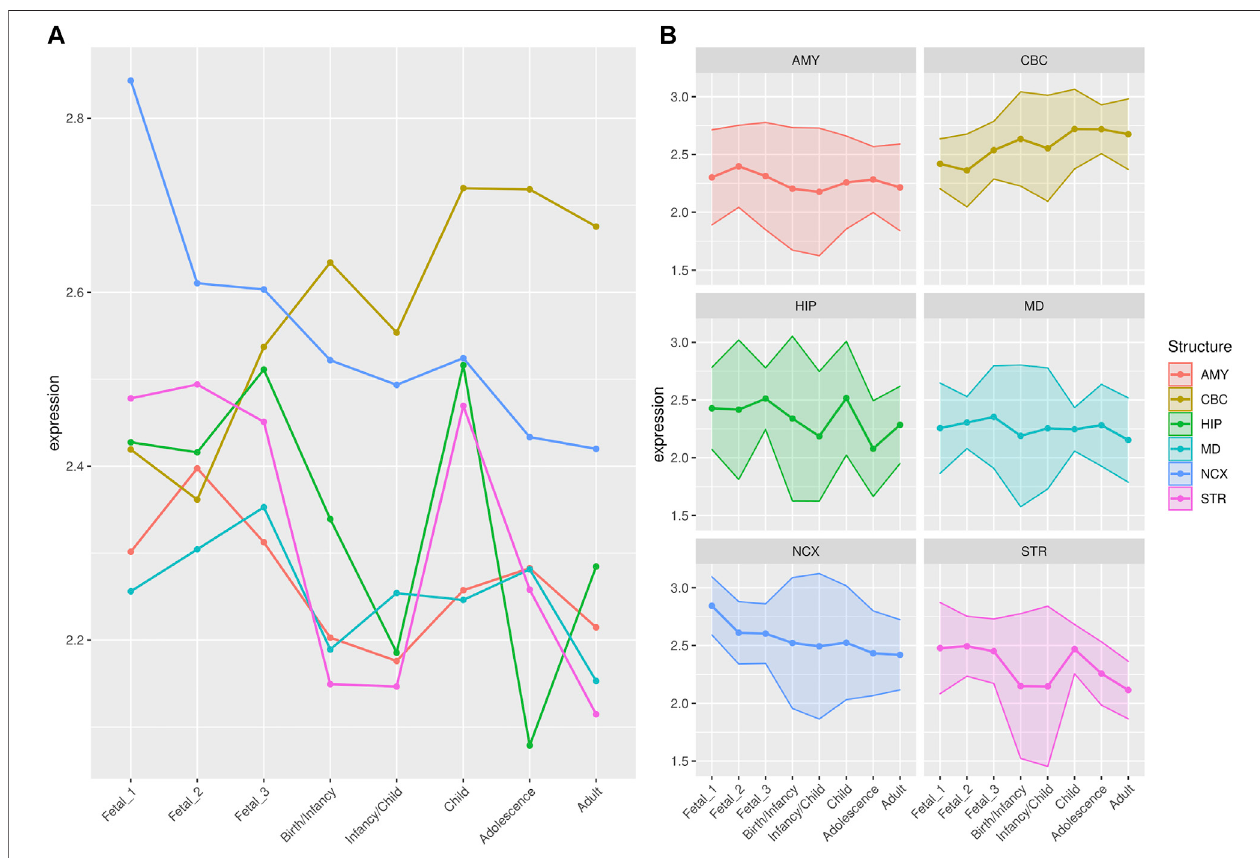
FIGURE3| Medianexpressionofgenesunderputativepositiveselectionwithinlargedeserts. (A) Comparisonofmedianofgeneexpressionacrossdevelopmental stagesbetweenstructuresand (B) Standarddeviationperstructure,forgenes( n =12)withinthefourlargedesertsofintrogressionandunderputativepositiveselection. Genesexpressed inneocorticalareasreachthehighestexpression attheearlyfetalstages,whereasthecerebellarcortex,frombirthuntiladulthood,retainsitsstatusas the structure with the highest expression pro fi le. The expression pro fi le of each of the twelve genes under putative positive selection within deserts is shown in Supplementary Figure S13 . Structures: AMY, amygdala; CBC, cerebellar cortex; HIP, hippocampus; MD, mediodorsal nucleus of thalamus; NCX, neocortex; STR, striatum. Stages: Fetal1:12-13postconceptionweeks(PCWs);Fetal2:16-18PCW;Fetal3:19-22PCW;Birth — Infancy:35-37PCWand0 – 0.3years;Infancy —